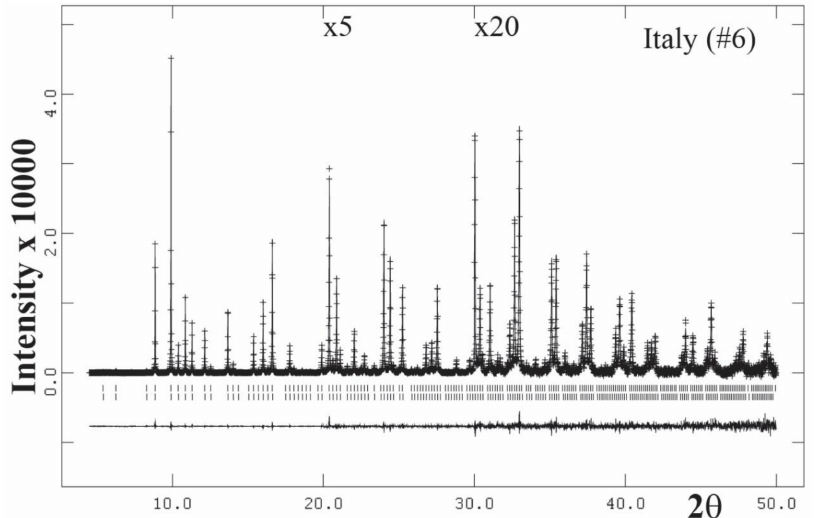
Figure 14. Complete HRPXRD trace for sample-6 from Italy. Data for sample-6 was modelled using two slightly different cubic